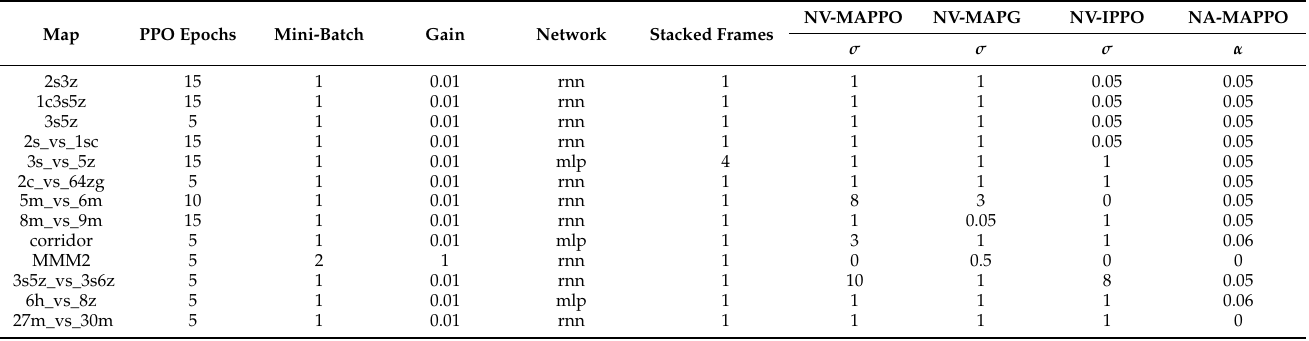
Table A1. Hyperparameters for IPPO and MAPPO and their noisy variants in